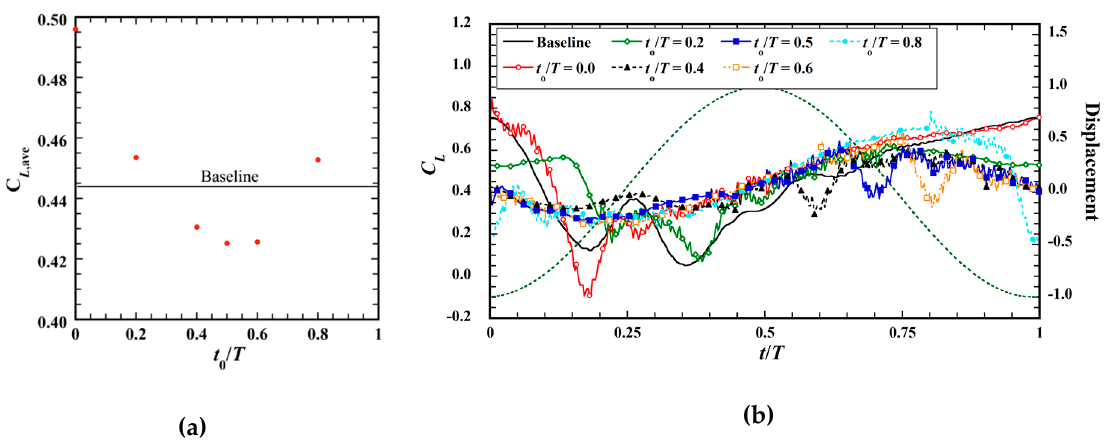
Figure 19. Lift with each time offset for the control only on the top surface ( R = 50%). ( a ) Time-averaged lift coefficient; ( b ) Time fluctuations of lift coefficient. Figure 20. Iso-surfaces of second invariant of velocity gradient tensor and contours of pressure coefficient around oscillating plate under the condition of t 0 / T = 0.5. (a) t / T = 0.18; (b) t / T = 0.75; (c) t / T = 0.94.